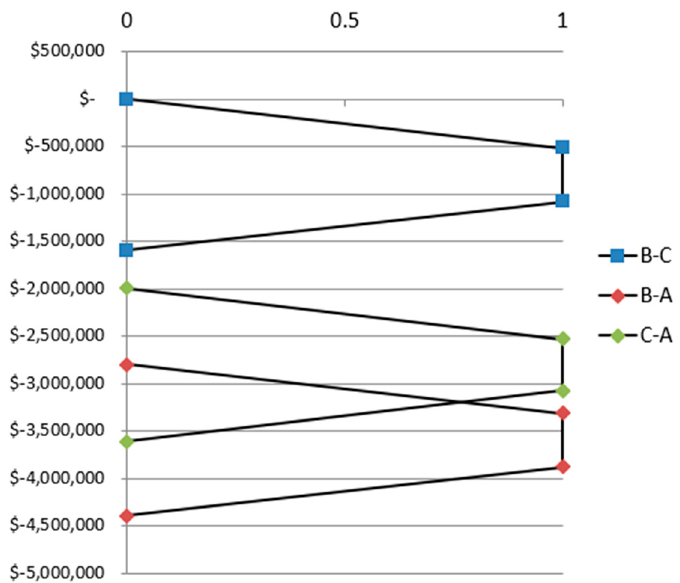
Figure 7. Dependence recognised with the difference in scenarios A, B and C.